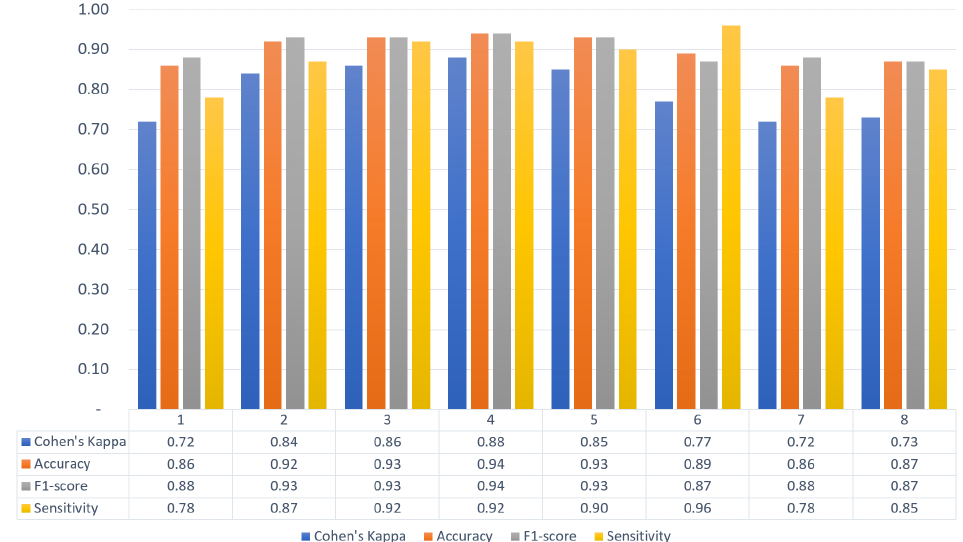
Figure 8. Leave-one-out validation of the